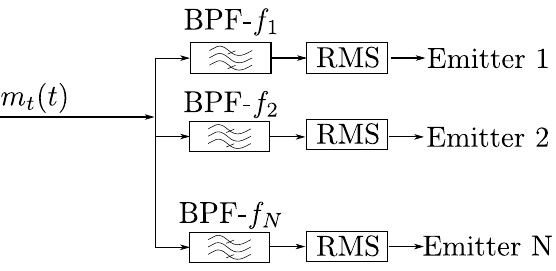
Figure 4. Bandpass filter diagram of one of the